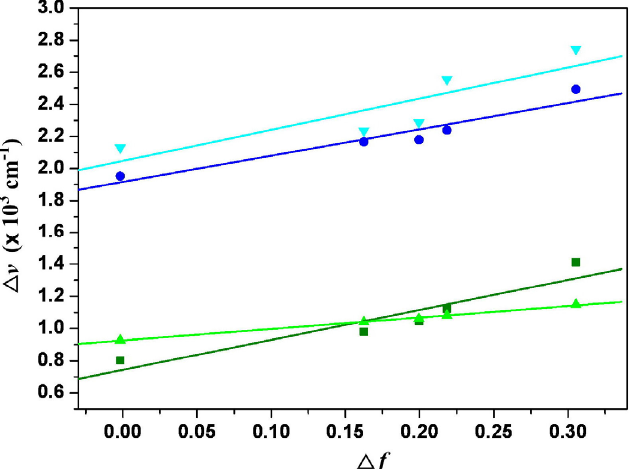
Figure 6. Lippert–Mataga plots for 1a (olive line), 2a (blue line), 3a (green line), and 4a (cyan line). The solvents from left to right are (1) cyclohexane, (2) diethyl ether, (3) ethyl acetate, (4) dichloromethane, (5)